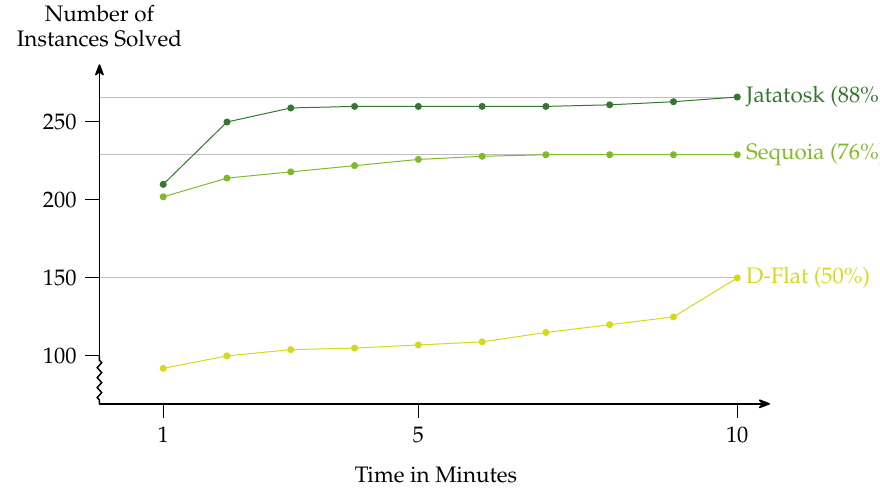
Figure 7. The cactus plot is the sum of the plots from Figures 2–6. Over all experiments, there are 300 instances in total that were tested. Jatatosk solves 88% of these, while Sequoia only manages to solve 76% and D-Flat 50% of the instances.